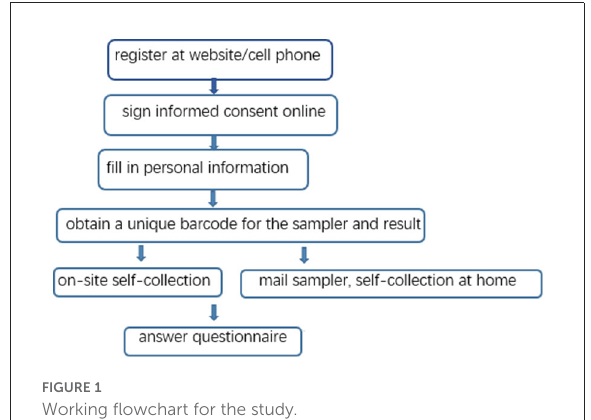
FIGURE1 Working flowchart for the